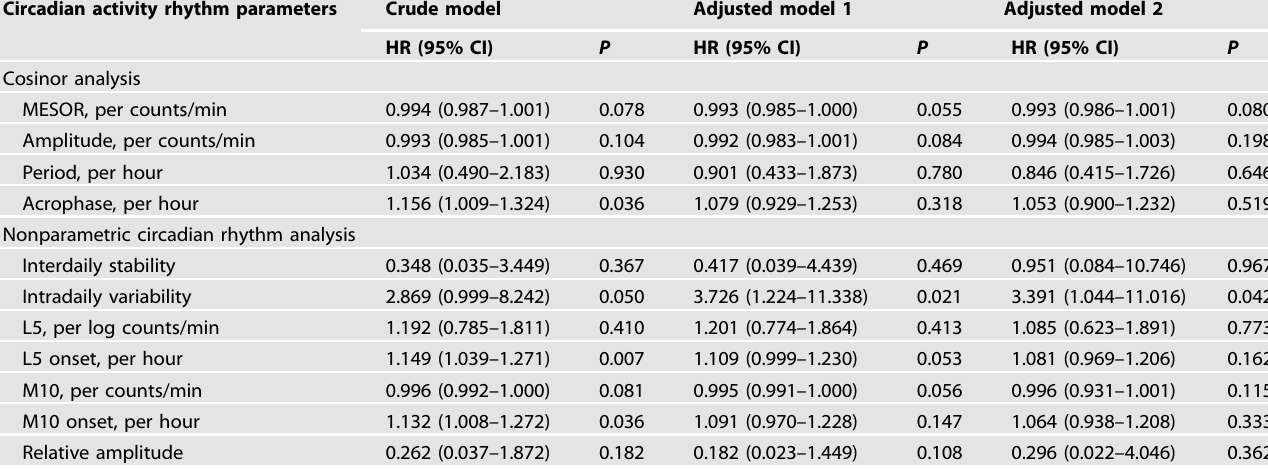
Table 4. Cox proportional hazards analysis for relapse of manic/hypomanic/mixed episodes associated with circadian activity rhythm parameters. Circadian activity rhythm parameters Crude